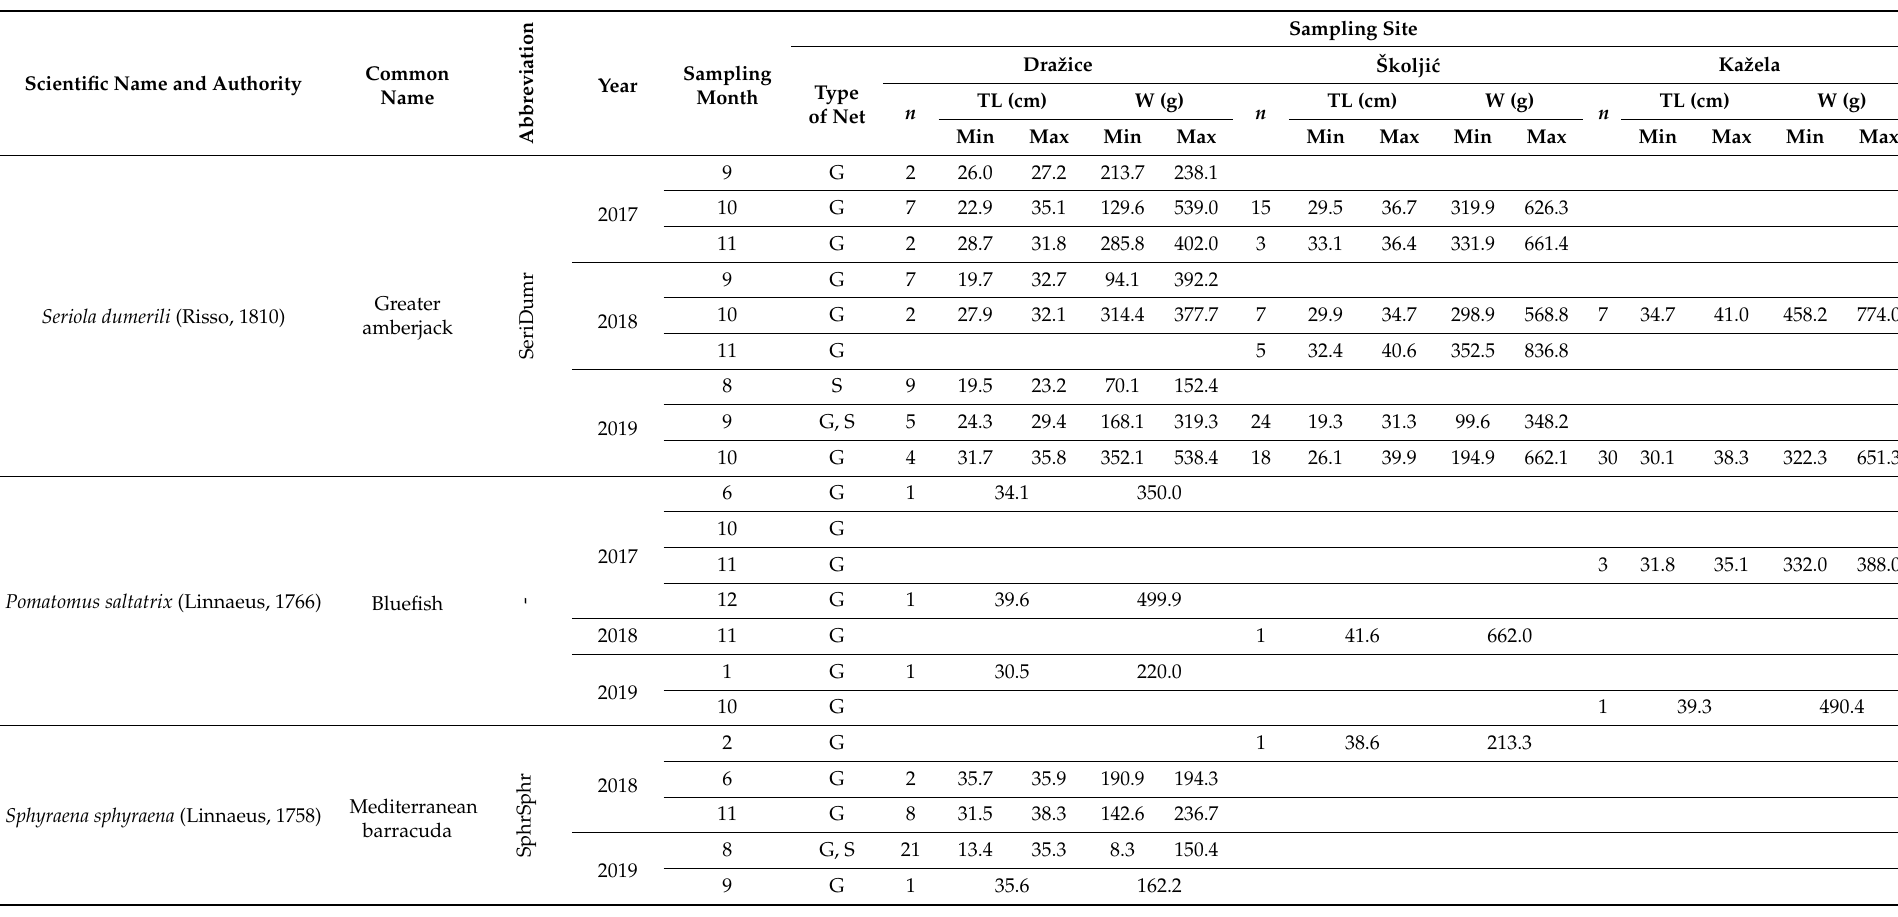
Table A1. List of the seven sampled fish species, their scientific and common names, abbreviations, sampling sites, the total number of specimens caught in each sampling month ( n ), minimal (min) and maximal (max) total length and weight, and type of net used from 2017–2019 from the Medulin bay, Istria (G = gillnet; S = coastal purse seine